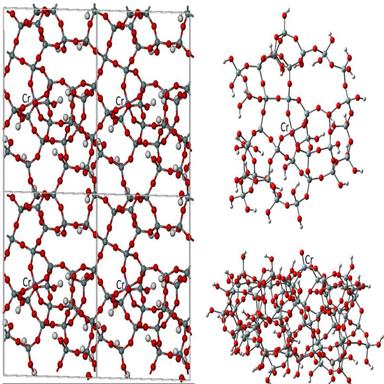
Example models of monomeric (top) and dimeric (bottom) Cr oxide species at various oxidation states on the partially dehydroxylated silica surface. Adapted from ref.. Copyright © (2017) with permission from Elsevier.